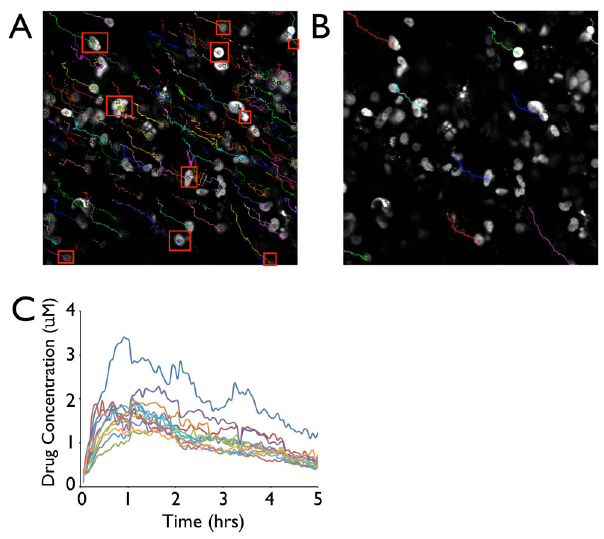
Figure 6. Single Cell Pharmacokinetic Tracking. The segmenta- tion algorithm was combined with a linking program to determine individual cell nuclear drug concentrations. A. The locations of cell nuclei were tracked over 5 hours, using external linking software in a video where both cell movement and image drift were present. Red boxes indicate arbitrarily selected cells used for manual tracking verification of the algorithm. B. Manual tracking of arbitrarily selected cells. C. By combining results using the segmentation algorithm together with the tracking data, drug concentration over time in 10 sample cells could be